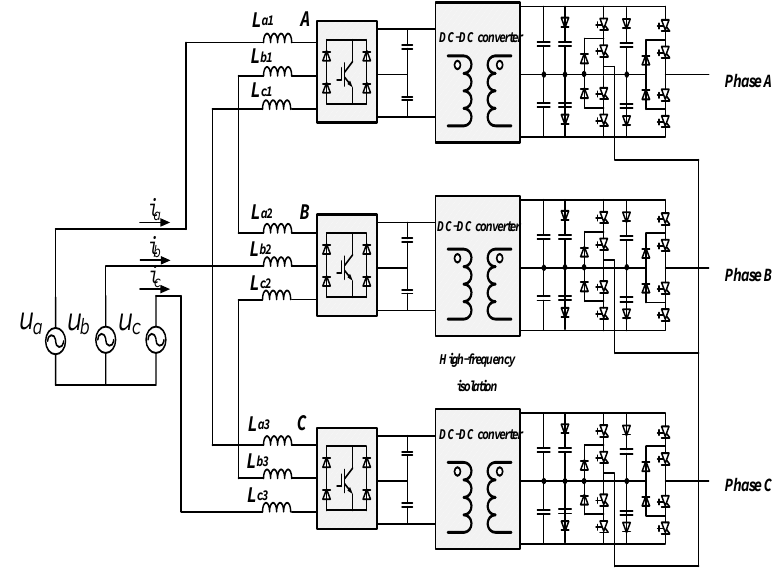
Figure 1. New topology of the medium voltage power converter.